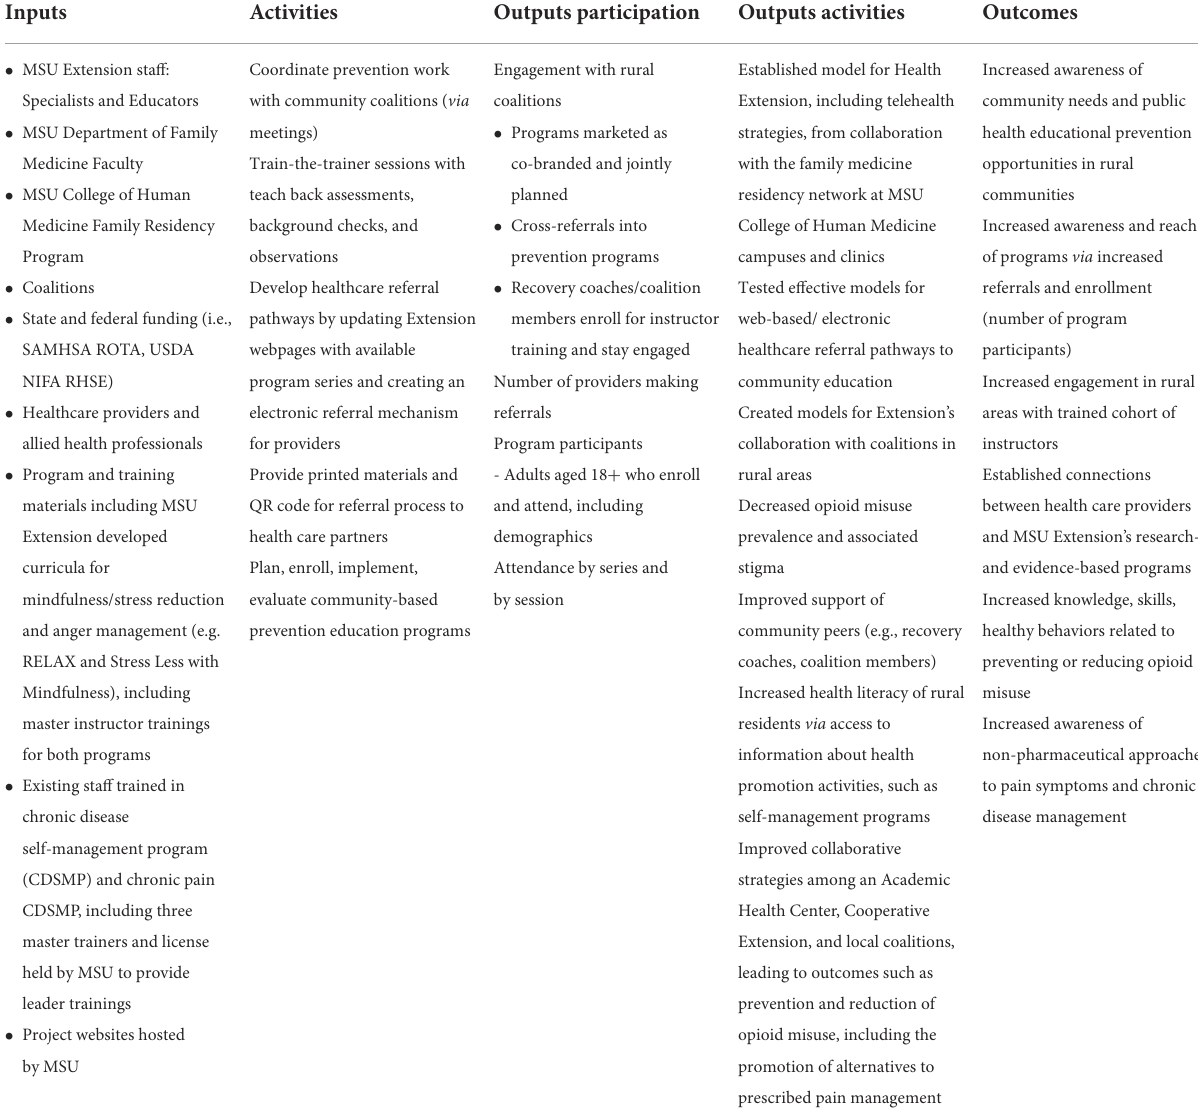
TABLE 2 Logic model for three cooperative extension initiatives funded to address Michigan’s opioid crisis.